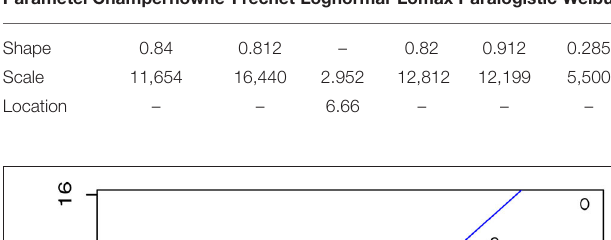
TABLE 13 | Parameter MLEs using truncated approach of the Champernowne, Frechet, Lognormal, Lomax, Paralogistic, and Weibull models.